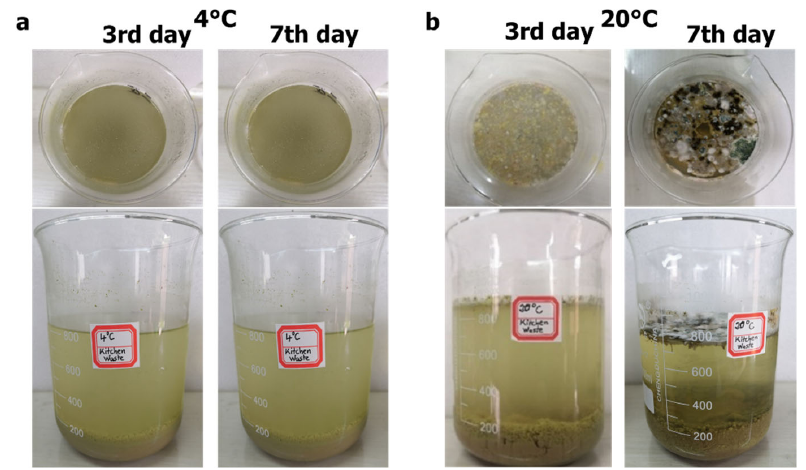
Figure 5. Appearance variation of samples at different temperatures and at different days: ( a ) 4 °C, ( b ) 20 °C.